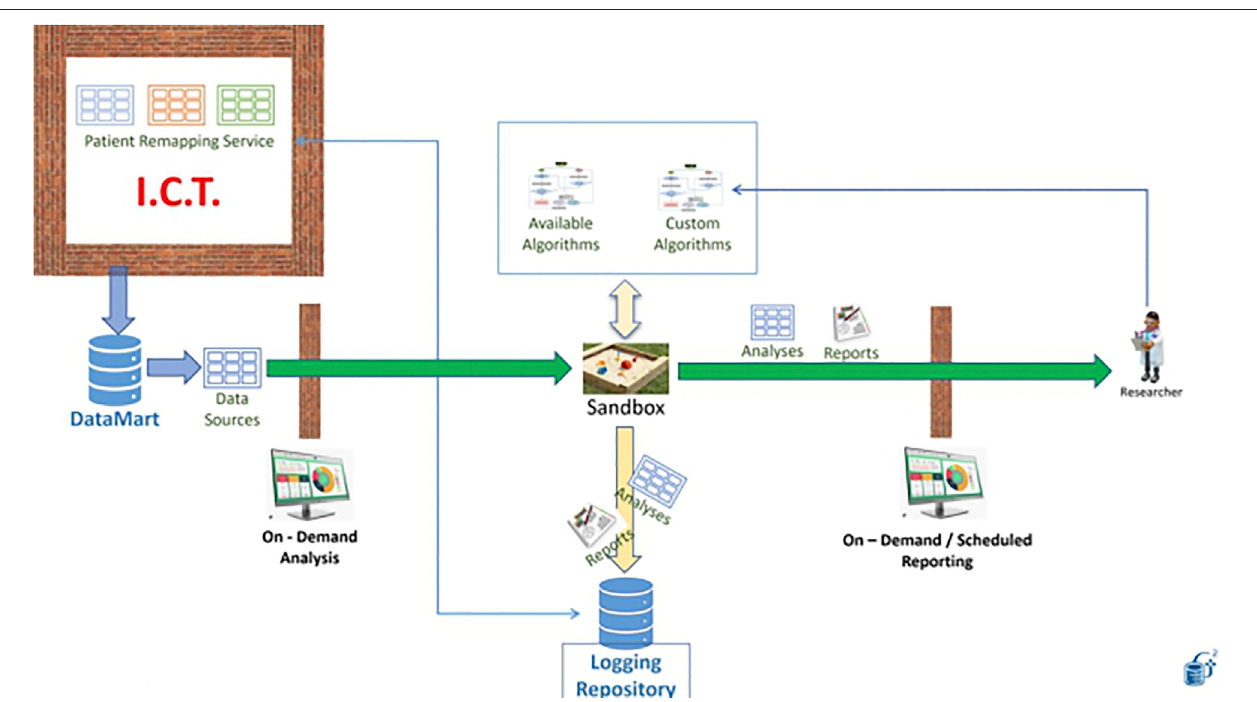
FIGURE 13 | A representation of the